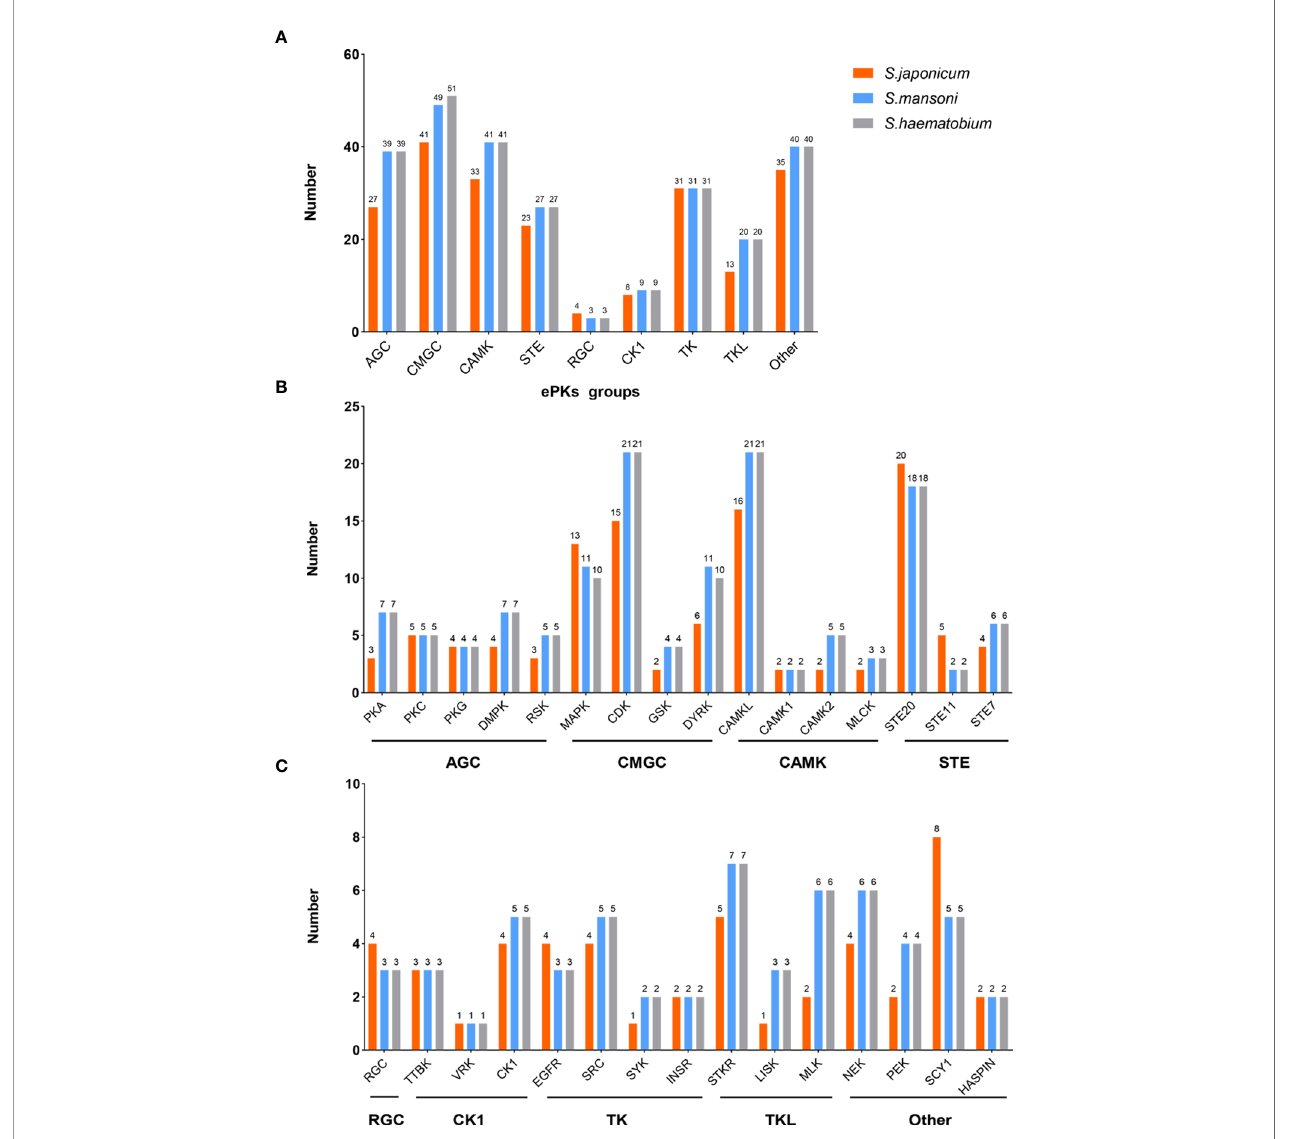
FIGURE 1 | The comparison of ePKs groups and main families of three species of schistosomes. (A) The classi fi cations of ePKs groups among three schistosomes including AGC, CMGC, CAMK, STE, RGC, CK1, TK, TKL, Other. (B) The classi fi cations of ePKs main families in different groups (AGC, CMGC, CAMK, STE). (C) The classi fi cations of ePKs main families in different groups (RGC, CK1, TK, TKL,